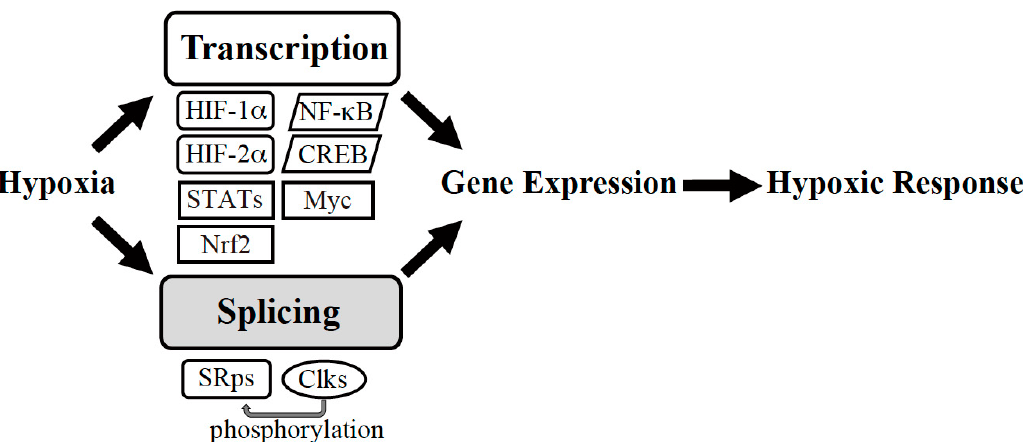
Figure 1. Gene expression machinery under hypoxia. Hypoxic conditions trigger transcription and 23 splicing to induce expression of gene sets required for hypoxic adaptation. HIF: Hypoxia-Inducible 24 Factor, NF- κ B: nuclear factor-kappa B, CREB: cAMP-response Element-binding Protein, Nrf: NF-E2- 25 related factor, STATs: signal transducers and activators of transcription, SRps: serine-arginine-rich 26 (SR) proteins, Clks, Cdc2-like kinases. 27